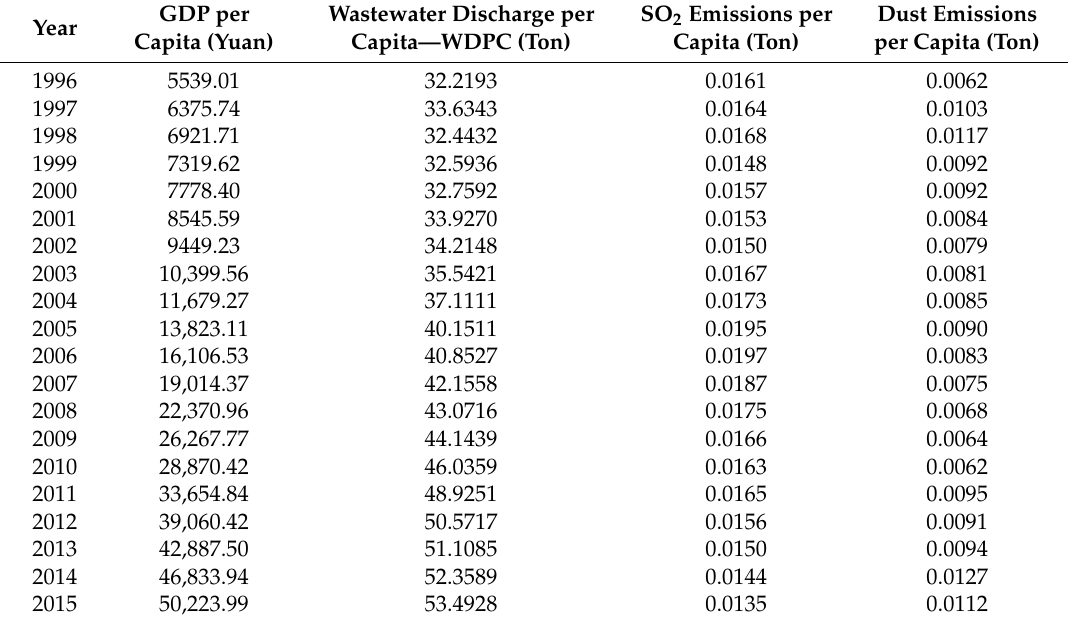
Table 1. The actual value of GDP per capita and emissions of three pollutants from 1996 to 2015.